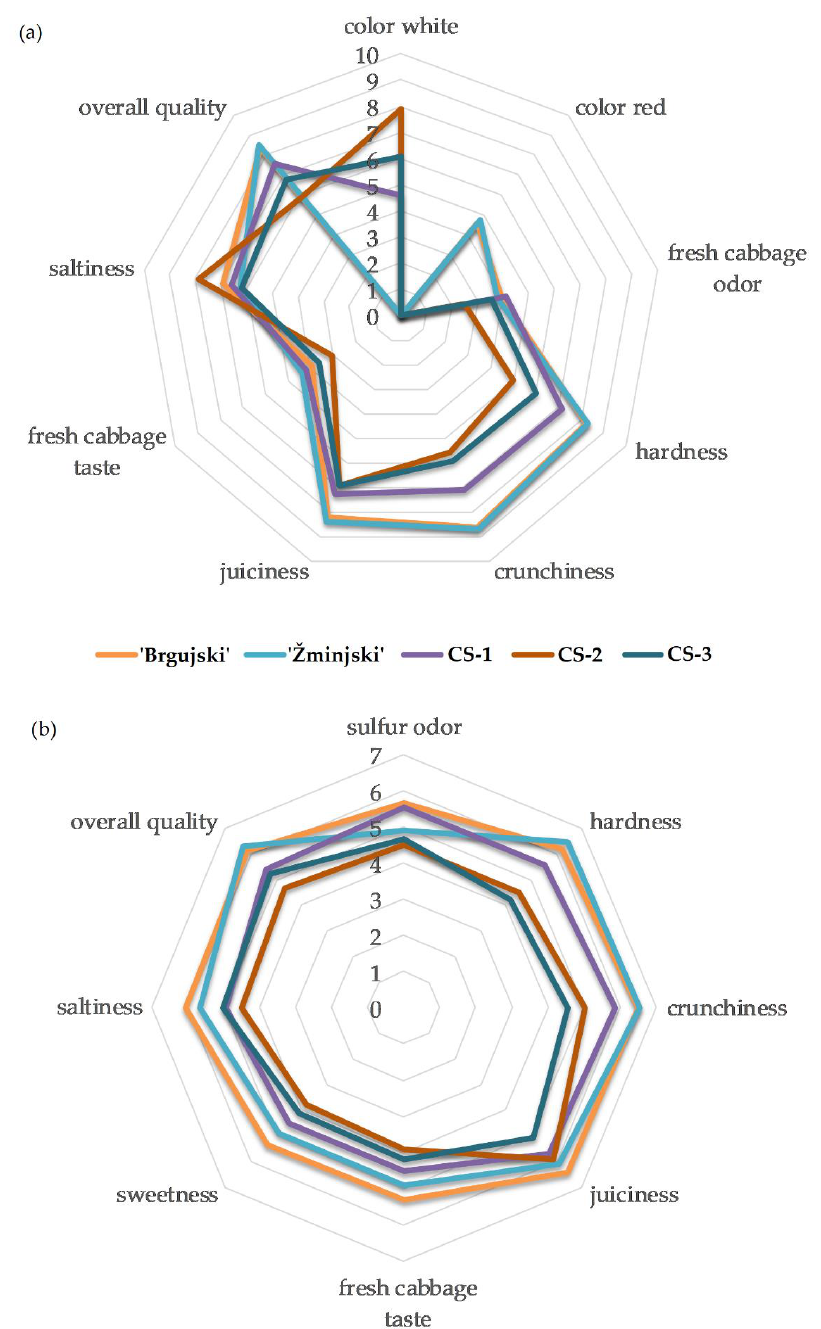
Figure 3. Sensory scores of sauerkraut samples from ‘Brgujski’ and ‘Žminjski’, and commercial sauerkrauts (CS-1, CS-2, and CS-3) obtained by the ( a ) QDA method and ( b ) Hedonistic scale. The results are shown only for significantly different sensory attributes after ANOVA according to Supplementary Tables S2 and S3.